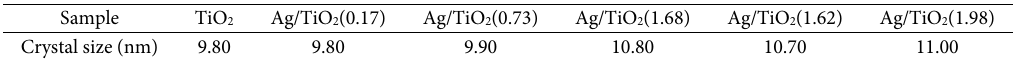
Table 1. Average crystal size of the synthesized nanoparticles calculated by Scherrer equation